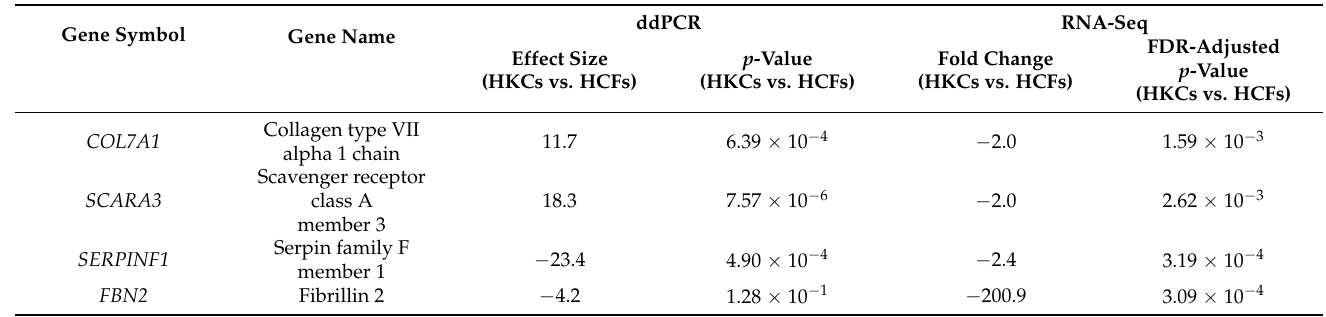
Table 6. Validated differentially expressed genes with ddPCR compared with RNA-Seq for Disease